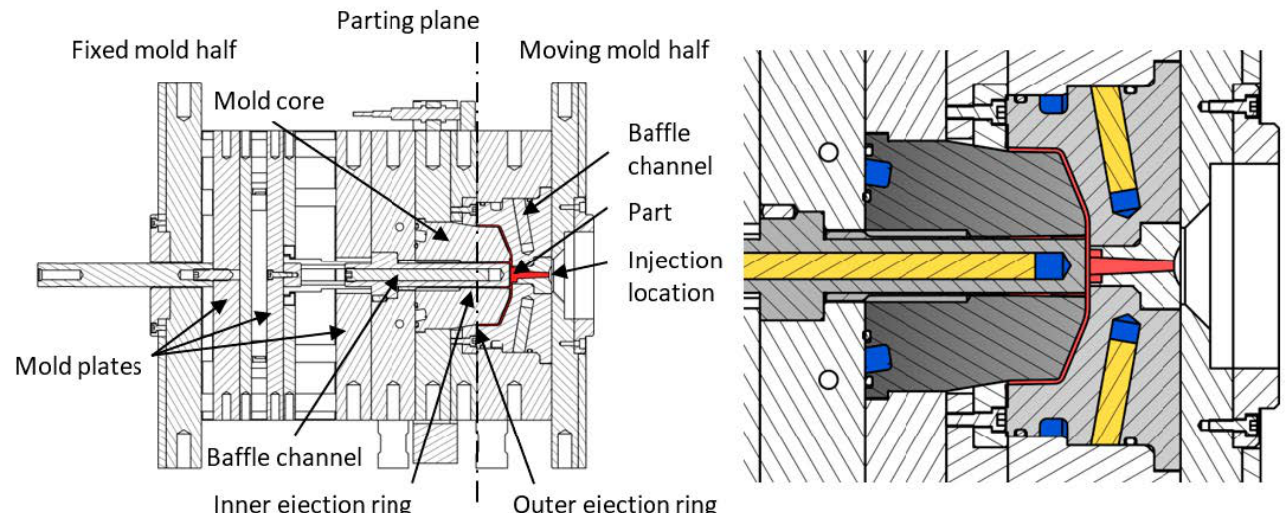
Figure 4. Experimental set-up: The injection molding tool ( left ); relevant detail of the tool for the cooling system ( right ). In the picture on the right, the molded part in the cavity is red; the mold core is dark grey; the inner core is light grey on the right; the die is light grey on the left. The observable cooling channels are in blue and divided by pass partition plates in yellow.